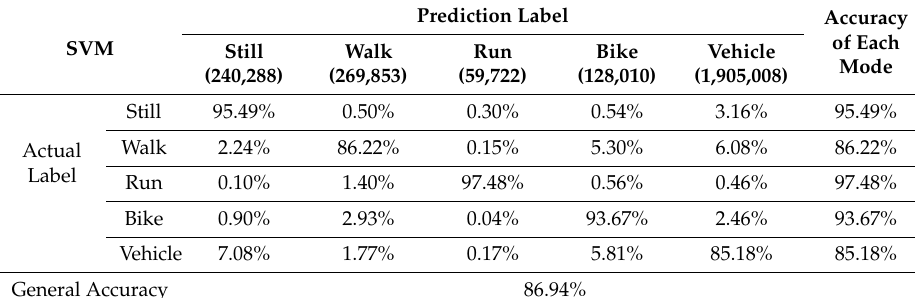
Table 6. Confusion matrix support vector machine with the proposed 14